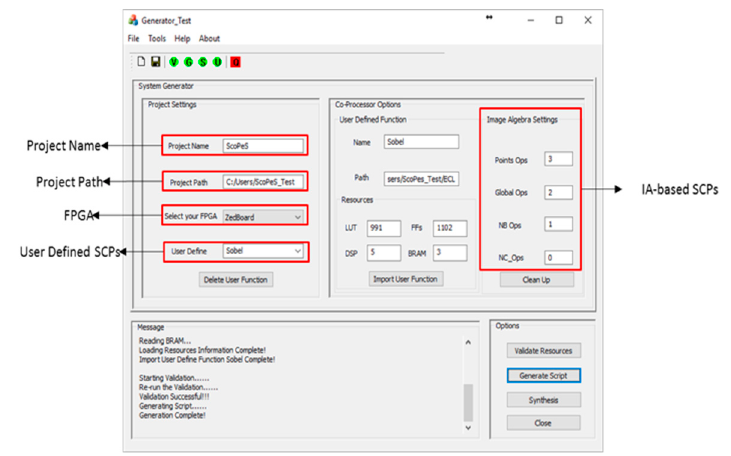
Figure 3. The GUI for creating a new project configuration.